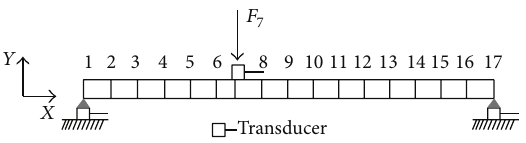
Figure 4: Simply supported steel beam showing the positions of the transducers used to measure the applied and reactions